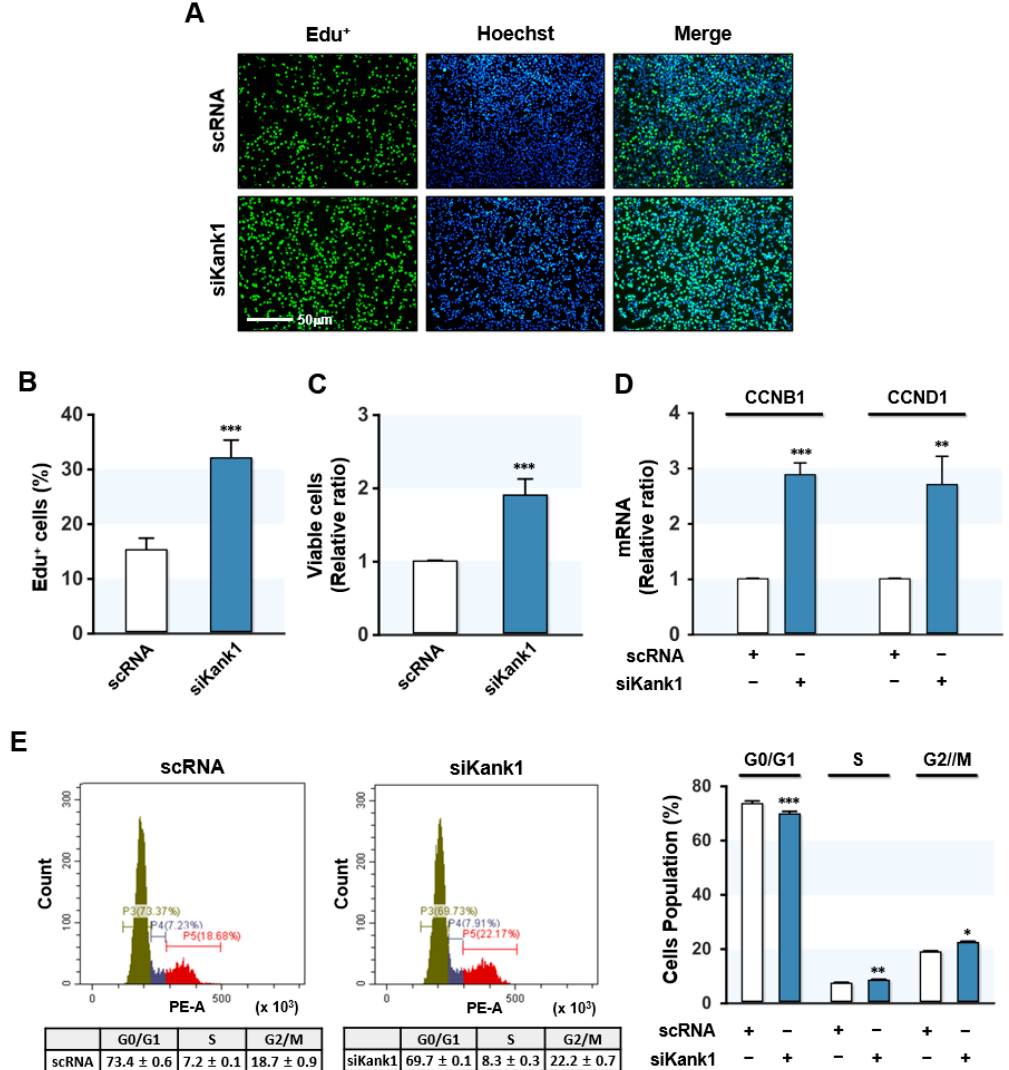
Figure 3. Kank1 knockdown promoted myoblast proliferation and cell cycle progression. C2C12 cells were transfected with control (scRNA) or Kank1 siRNA (siKank1) for 24 h. ( A ) The cells undergoing DNA replication were labeled with EdU (green), and nuclei were stained with Hoechst 33,342 (blue). Scale bar, 50 μ m. (B) Percentages of EdU-positive cells were determined using ImageJ software. ( C ) Viable cells were quantified using a cell viability assay kit. ( D ) The mRNA levels of CCNB1 and CCND1 were analyzed by q RT-PCR and normalized versus GAPDH. ( E ) Flow cytometry was used with a scatter plot for cell cycle analysis of myoblasts at 24 h after transfection. The graph